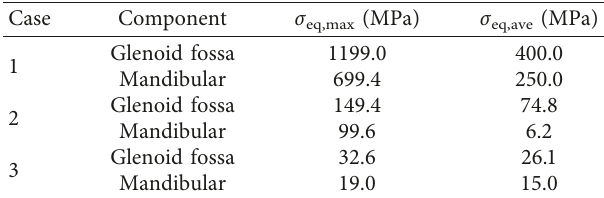
Table 6: Maximum and average Mises equivalent stresses at the contact